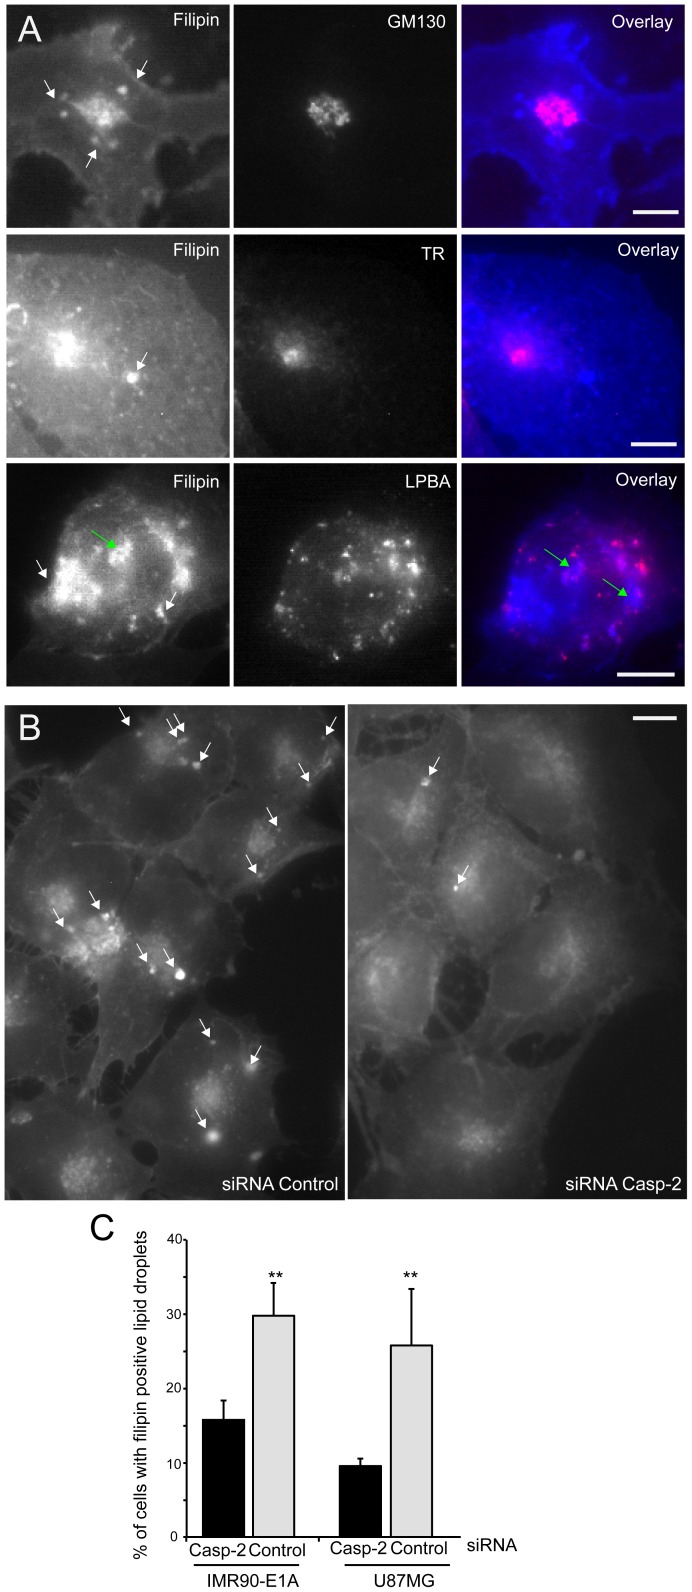
Cholesterol distribution in cells silenced for caspase-2 expression.A. U87MG cells were fixed and processed for immunofluorescence. Epifluorescence microscopy followed by deconvolution analysis was used to visualize different subcellular compartments and cholesterol distribution. With arrows indicate LDs and green arrows LDs encircled by lysosomes. Scale bar 40 µM. B. U87MG cells were transfected with siRNA against caspase-2 or control siRNA as indicated. 48 h later cells fixed and stained with filipin to visualize the intracellular distribution of cholesterol. Arrows point to LDs. Scale bar 30 µM. C. Quantitative analysis of LDs presence in U87MG and IMR90-E1A cells transfected with siRNA against caspase-2 or control siRNA. Data are presented as mean ± SD; n = 3.